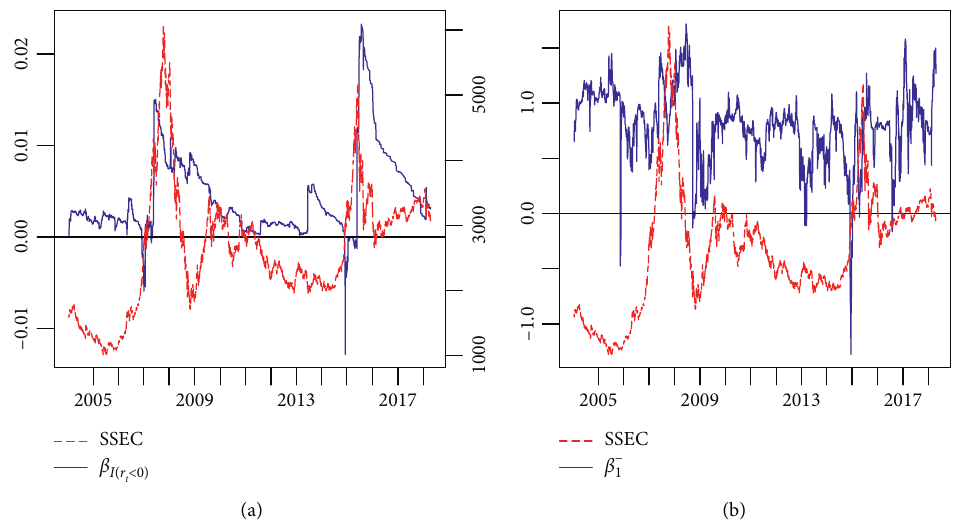
Figure 2: Time plots of “leverage parameter.” (a) Panel A and (b) Panel